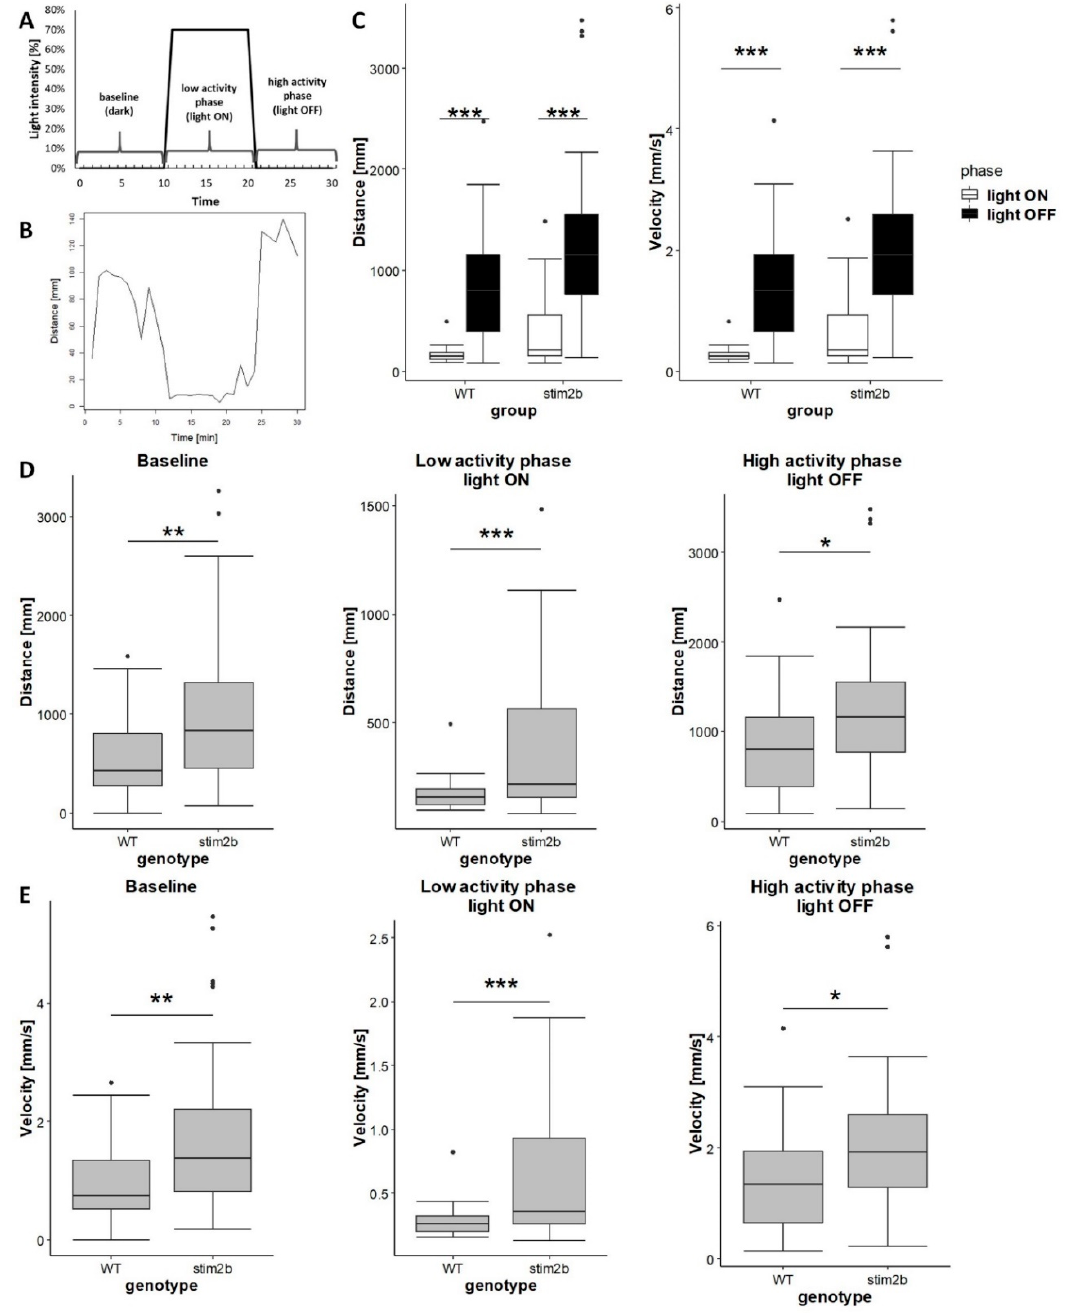
Figure 5. Light perception was unaffected in stim2b − / − larvae in the visual-motor response test, indicating hyperactivity of these mutants. ( A ) Experimental design that shows changes in light intensity during the experiment. Larva activity was recorded during a 30 min period that consisted of a baseline phase (0% light), inactive phase (70% light), and high activity phase (0% light). ( B ) Representative plot of the distance traveled by a single larva during 1 min of the experiment. The plot shows the response of WT larvae. ( C ) Boxplots of the distance traveled and velocity in WT and stim2b − / − larvae after turning the light on (in white) and o ff (in black). * p < 0.05, ** p < 0.01, *** p < 0.001, response to turning the light on vs. o ff for each genotype (paired t -test). ( D ) Boxplots of the distance traveled and ( E ) velocity in WT and stim2b − / − larvae during each phase of the experiment. * p < 0.05, ** p < 0.01, *** p < 0.001, mutant vs. WT (Wilcoxon rank-sum test). Number of larvae: n = 36 WT, n = 35 stim2b − / − . Number of experiments: